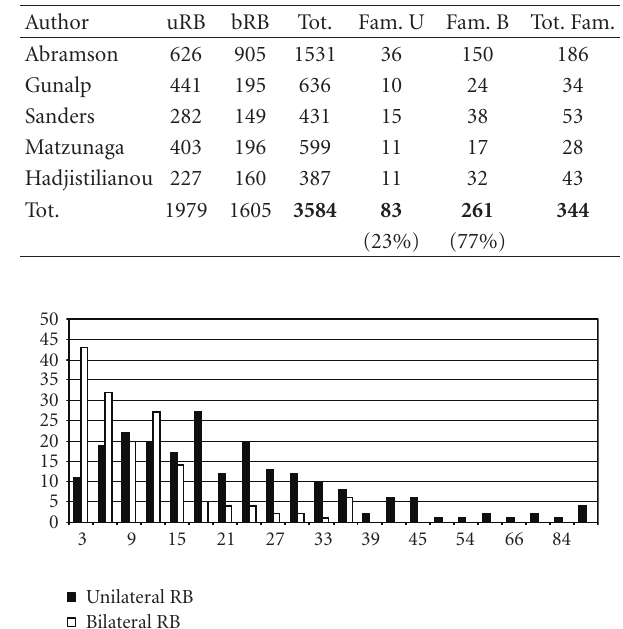
Table 3: A meta-analysis of literature shows that within a total of 344 familial retinoblastoma, 83 (23%) showed the unilateral phenotype.